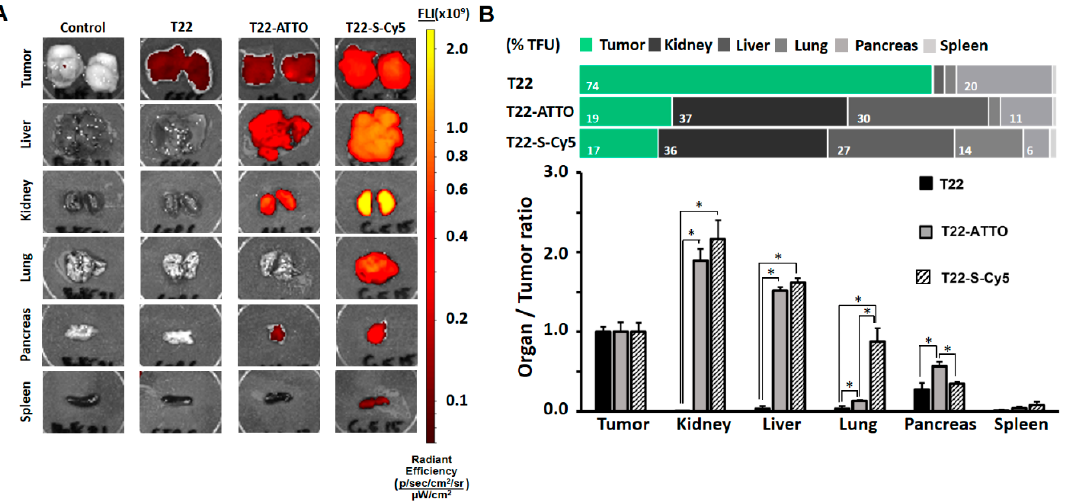
Figure 4. Biodistribution in subcutaneous DLBCL mouse model. ( A ) Images of tumor and non-target organ sections of DLBCL mouse model at 5 h upon administration of buffer (Control), T22-GFP-H6 (T22) nanoparticles or labeled T22-GFP-H6-ATTO (T22-ATTO) and T22-GFP-H6-S-Cy5 (T22-S-Cy5)